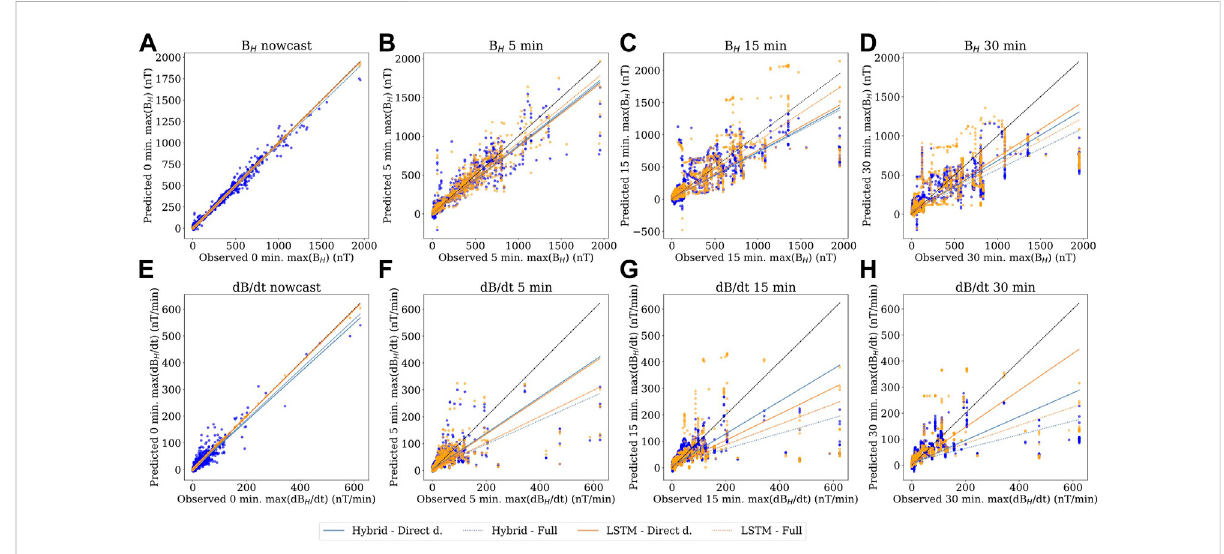
FIGURE 5 Correlation plots for now- and forecasts of |B_H| (A – D) and |dB_H/dt| (E – H) at5, 15 and 30 min leadtime atLER. Orange represents LSTM and bluehybridmodels;solidlinesarefordirectlydrivenpartsofthestormanddottedlinesrepresentfullstorm.Gradientandinterceptforbest fi tlineare given in Table 4. Dotted black line shows the 1:1 line for reference.